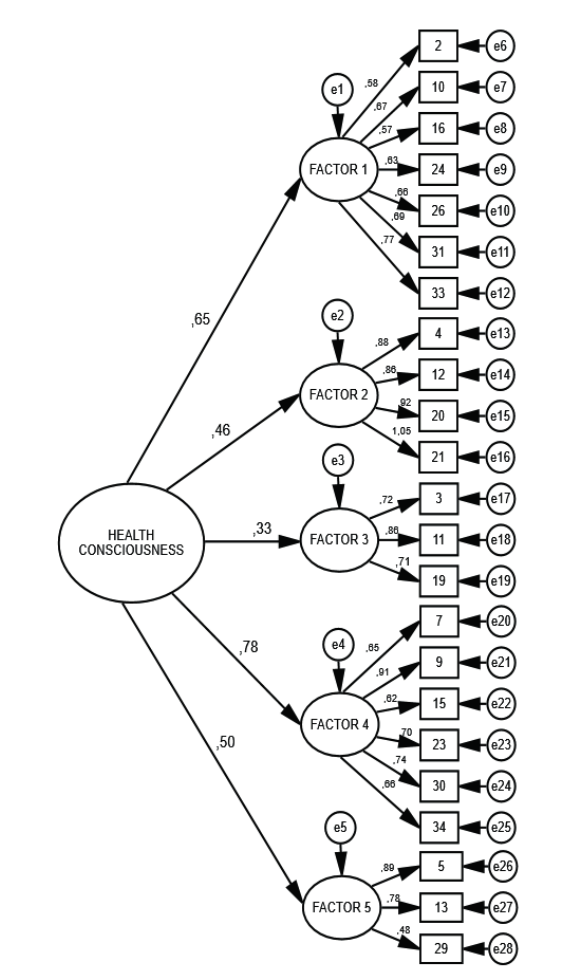
Fig. 1. Confirmatory factor analysis with standard